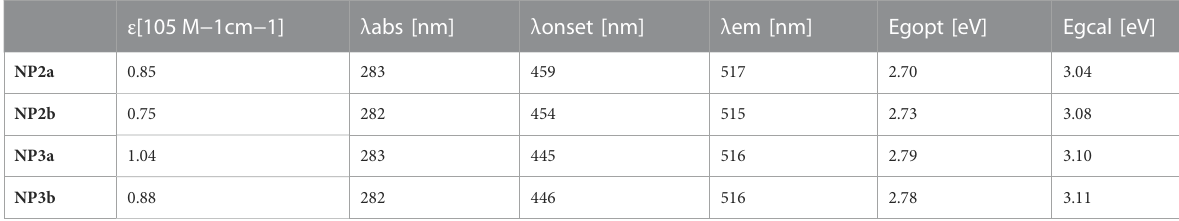
TABLE 1 Photophysical Properties and Energy Levels of the